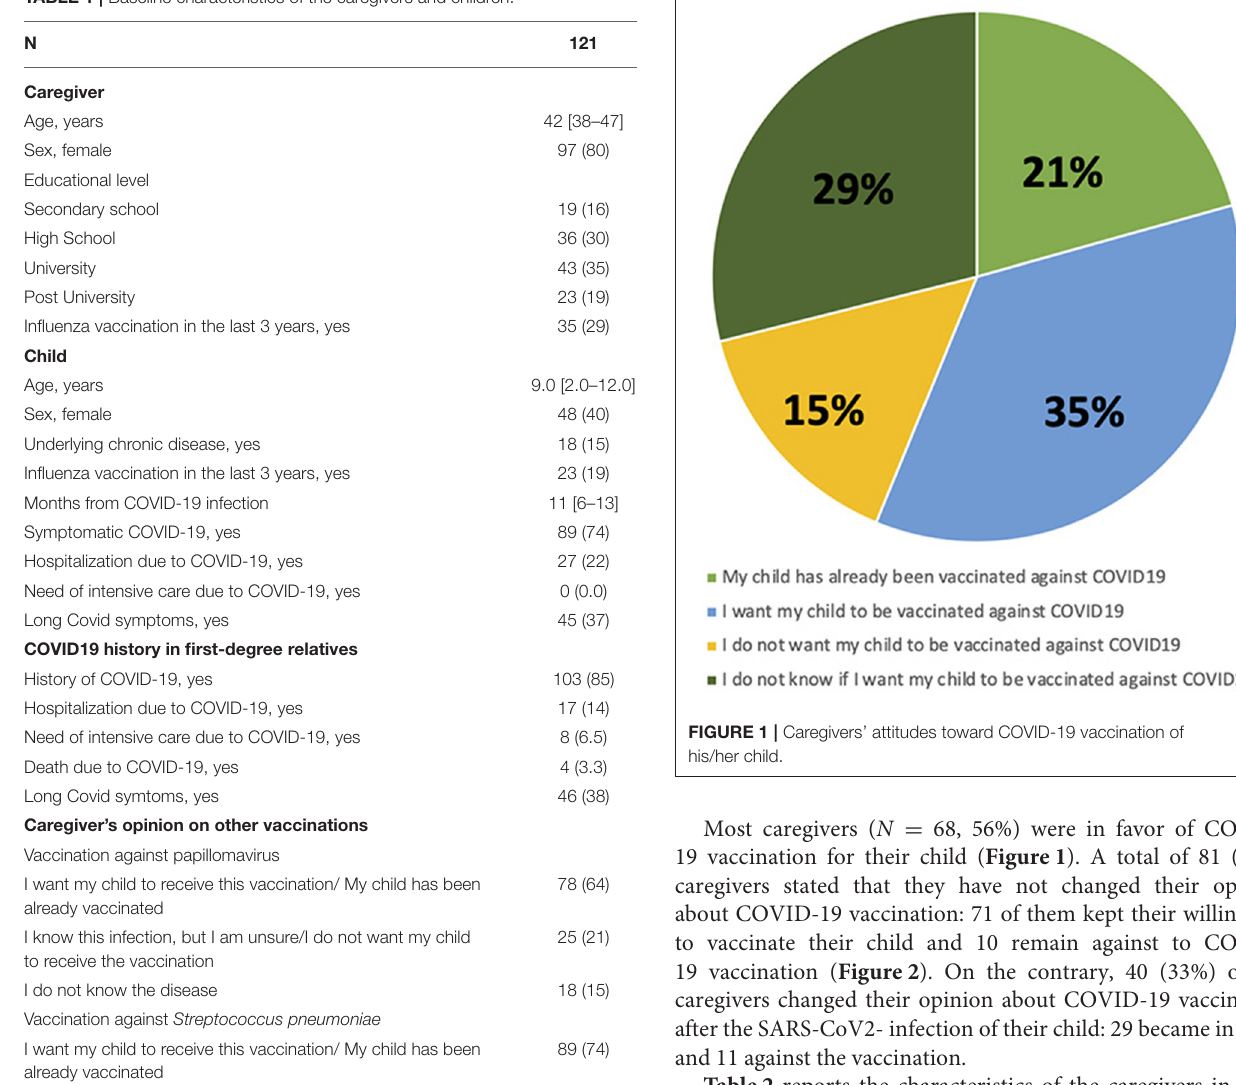
TABLE 1 | Baseline characteristics of the caregivers and children.